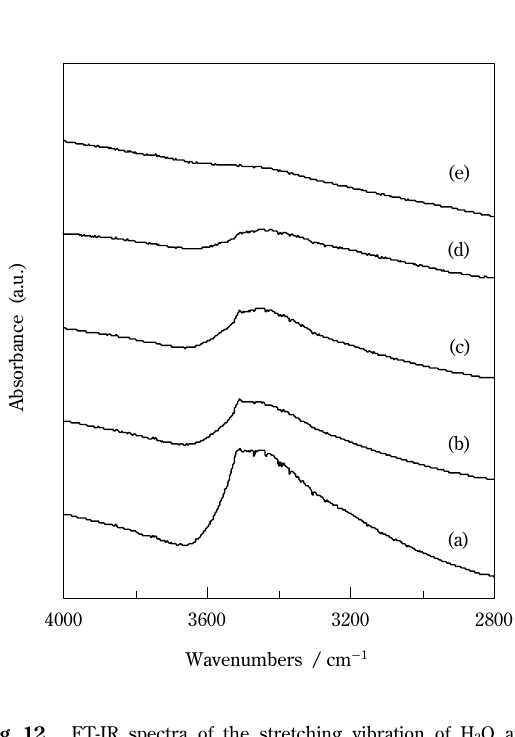
Fig. 12 FT-IR spectra of the stretching vibration of H 2 O and hydroxyl group in BaTiO 3 particles by sol-gel method (Flow rate (cid:3) 1.24 m/s): (a) as prepared, and treated for 60 min at (b) 300°C, (c) 500°C, (d) 700°C and (e)